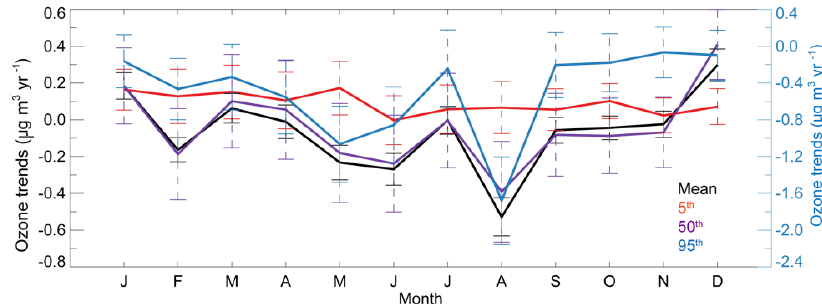
Figure 4. Monthly trend in the observed surface ozone averaged over Europe for the selected 93 sites. The black line shows the 1995–2014 linear trends in the European mean ozone for each month of the year, the red, purple and blue lines depict the observed trend for 5th, 50th, and 95th percentile ozone, respectively, and the dashed bars indicate their standard deviations. The left axis is for the trends of mean, 5th, and 50th percentile ozone, while the right axis is for the 95th percentile